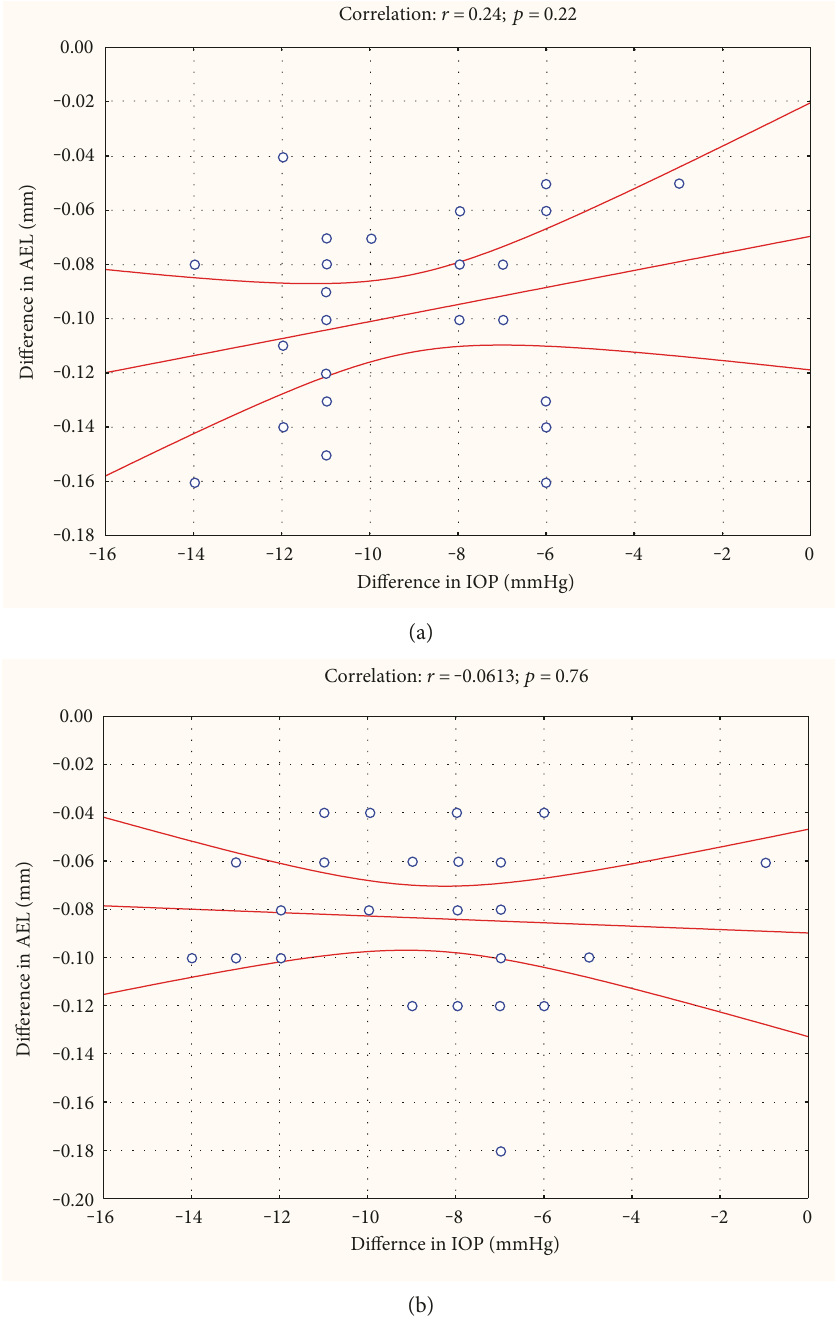
Figure 2: Correlation between changes in intraocular pressure (IOP) and axial eye length (AEL). Data are separately presented for 6 months after surgery (a) and for 12 months after surgery (b). The correlation line and the 95% con fi dence interval are